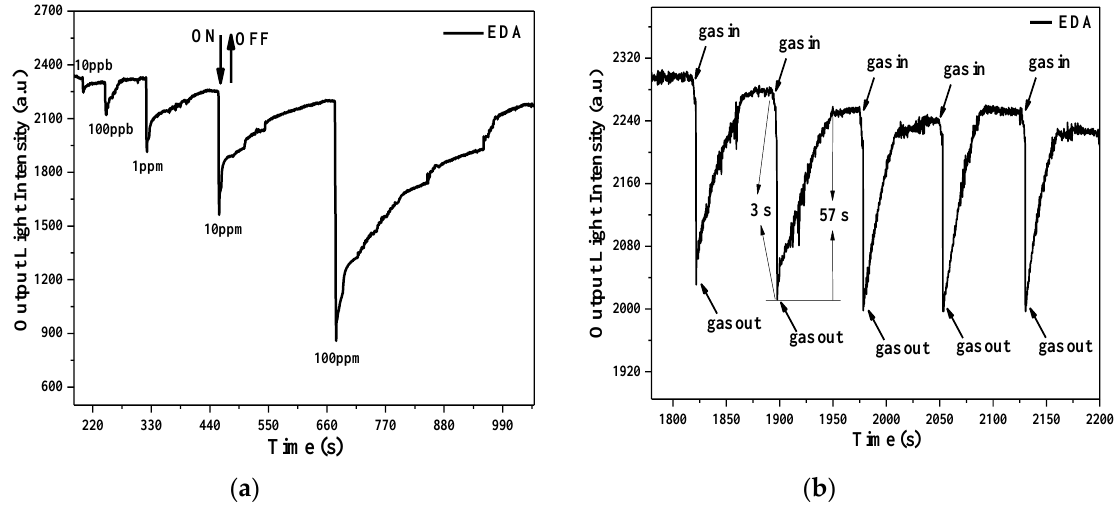
Figure 8. Nf-TNPP-film-based / K + -rxchanges OWG-sensor performance. ( a ) Response reproducibility and ( b ) response-recovery curve over 5 cycles for 100 ppb EDA gas.